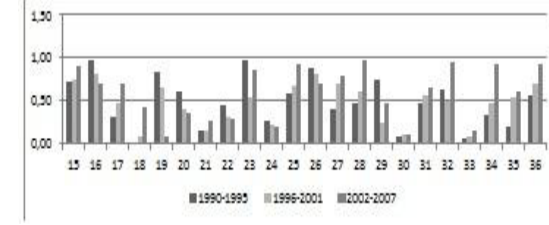
Figure 5. GL Index